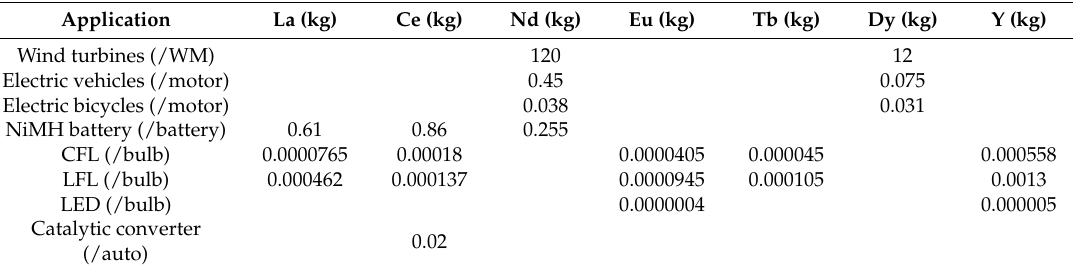
Table 2. The average volume of individual REE for clean technologies.